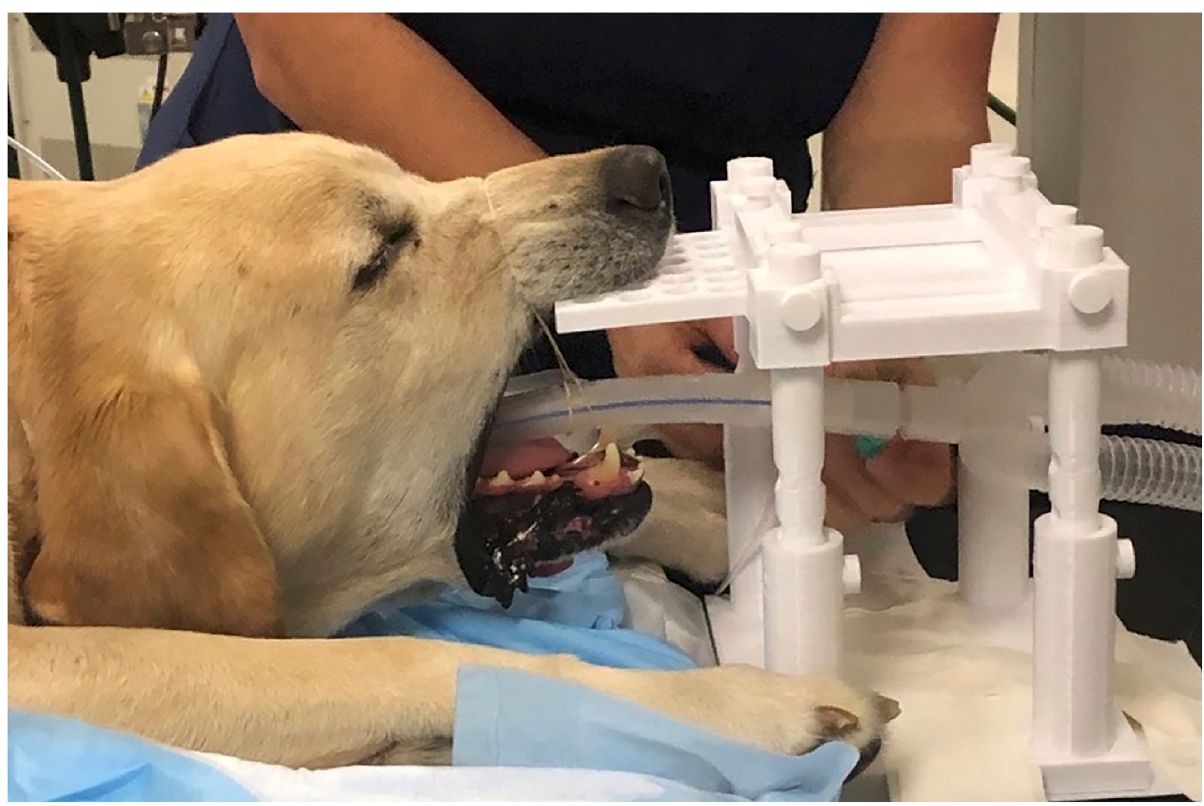
Fig 1. Positioning for indirect computed tomography lymphangiography (ICTL) procedure. A dog with an oral tumor positioned in sternal recumbency with the rostral maxilla positioned on a 3-D printed bite block in preparation for computed tomography (CT) scan. All dogs were positioned similarly to limit compression on the ventral neck for improve cervical drainage. CT images were subsequently acquired with pre- and post- contrast images followed by additional CT image acquisition 3, 6 +/-12 minutes (min) following peritumoral contrast injection.